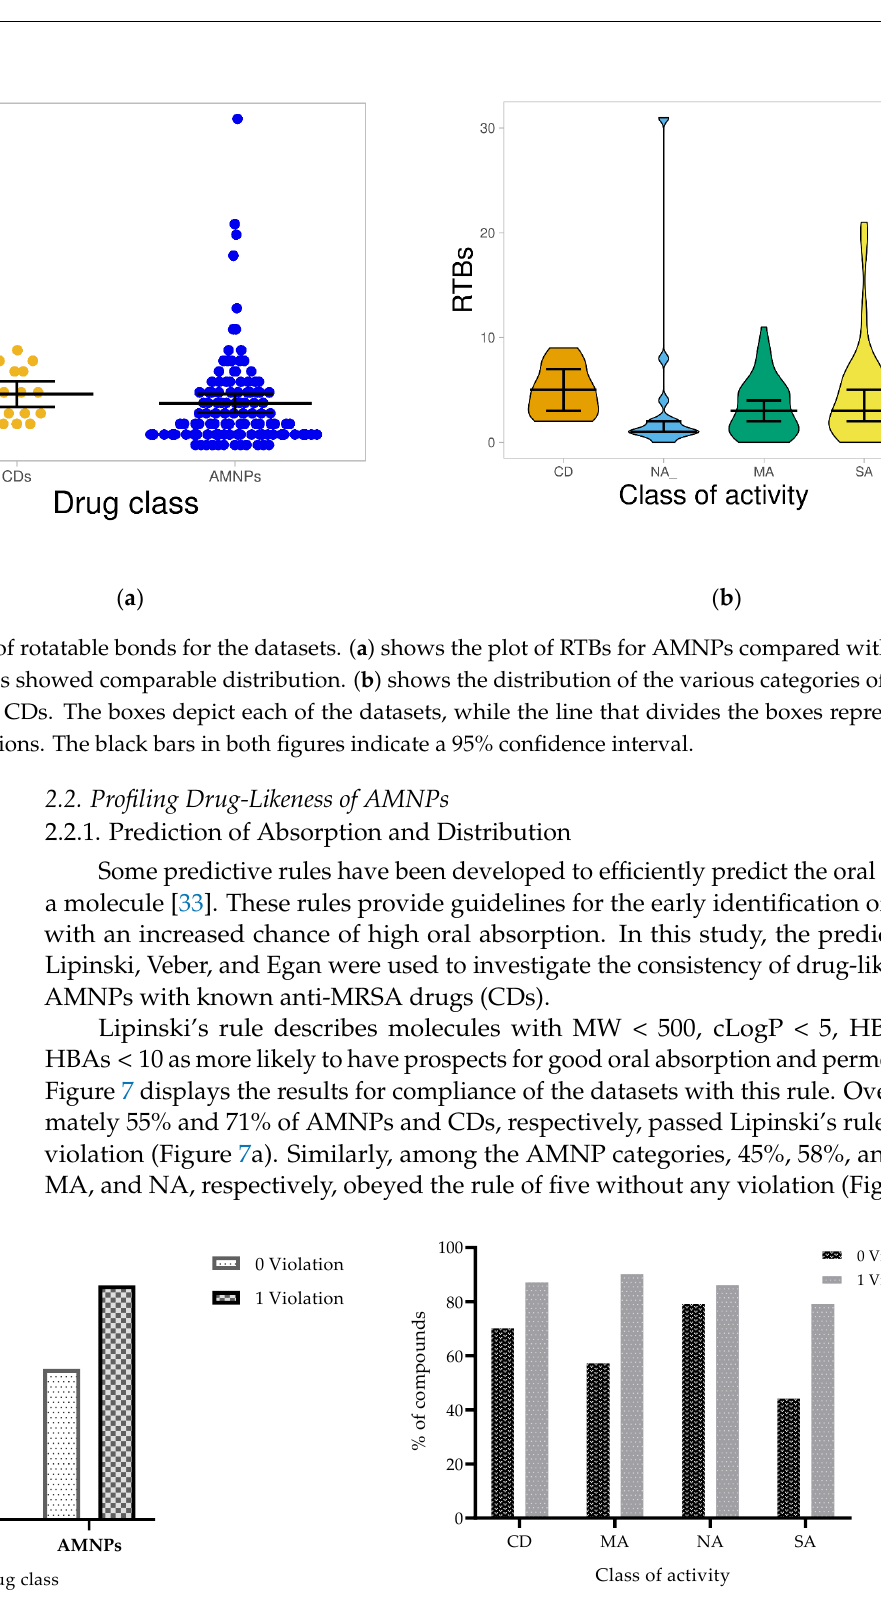
Figure 7. Histograms of the rule-of-five compliance based on the principle that drug-like compounds could break ≤ 1 of the rules. ( a ) shows that up to 71% and 55% of CDs and AMNPs, respectively, comply without any violation, while 85% of AMNPs violate not more than 1 of the rules. ( b ) shows that up to 88% of the CDs break not more than 1 of Lipinski’s rule, and among the AMNP categories, 45%, 58%, and 80% of SA, MA, and NA, respectively, obey the rule of five.